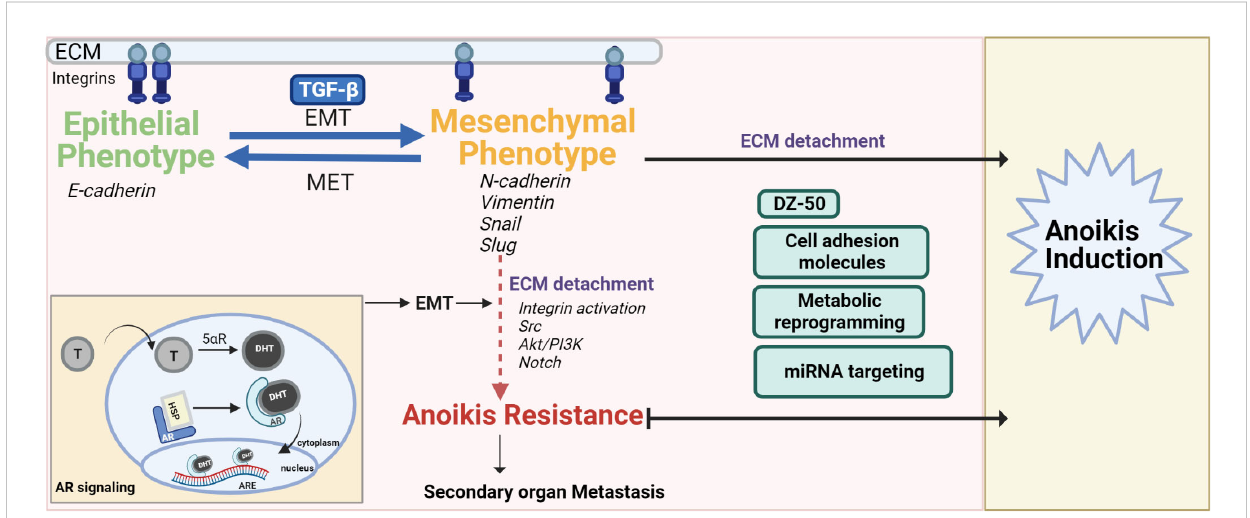
FIGURE 1 The interplay of EMT-MET maintains the pivotal balance between normal cell anoikis and cancer progression/anoikis resistance. The mesenchymal phenotype contributes to anoikis resistance after ECM detachment via activation/dysregulation of pathways such as androgen signaling, Akt/PI3K, Src and Notch signaling. Anoikis resistance can be overcome by drugs (DZ-50), regulating ROS balance, targeting miRNA or cell adhesion molecules that inactivate these pathways, push the switch in favor of MET and/or make the cancer cells anoikis